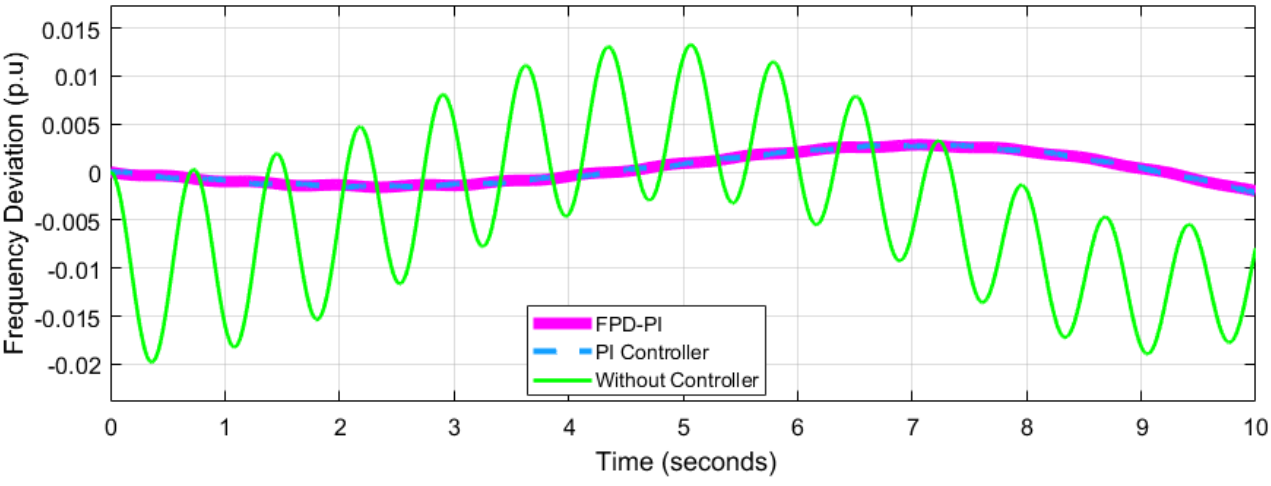
Figure 7. Case 4: frequency deviation at (K p = −1.881, K i = −0.0014) for network 1.